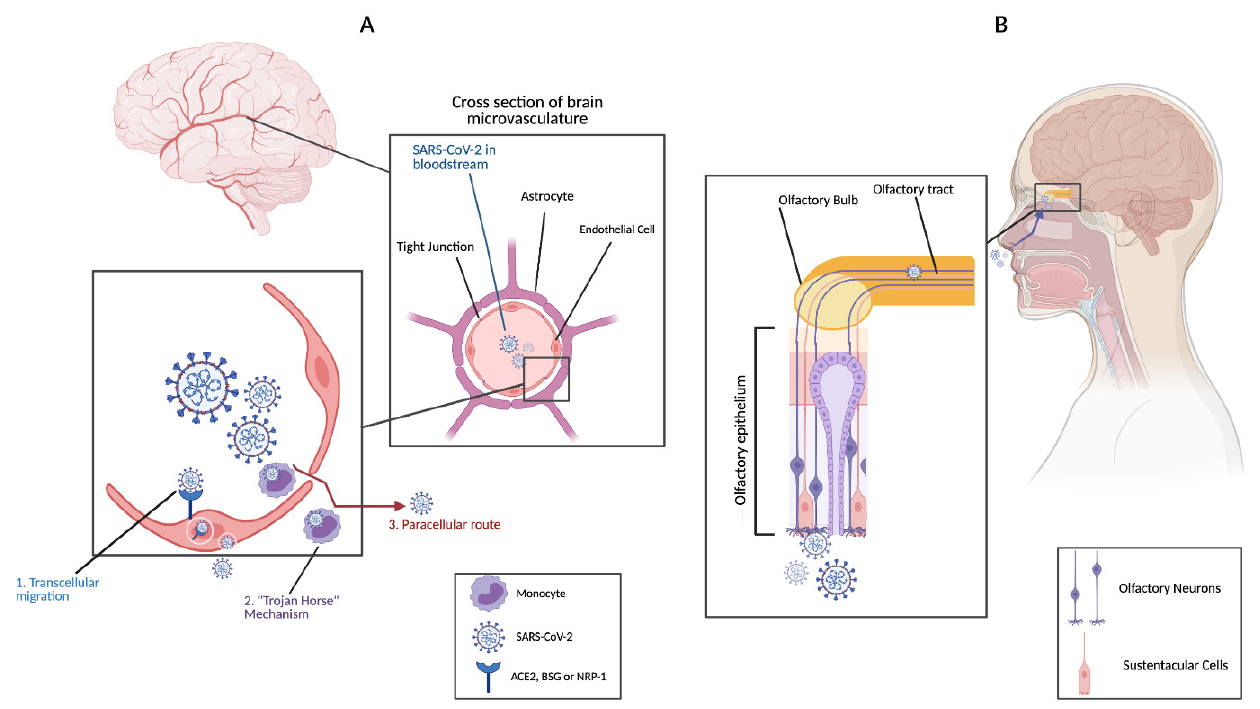
Figure 1. Mechanisms of SARS-CoV-2 invasion of the CNS. ( A ) Hematogenous route: Severe Acute Respiratory Syndrome Coronavirus-2 (SARS-CoV-2) invasion of CNS from the bloodstream is mediated by three mechanisms; 1. Transcellular migration which involves binding of the virus to its receptors; ACE2, basigin (BSG), or neuropilin-1 (NRP-1), on brain microvasculature endothelial cells then crossing endothelial cells via transcytosis, 2. Infecting immune cells which then carry the virus across the blood–brain barrier (BBB) endothelial cells into the CNS (Trojan Horse mechanism), and 3. Paracellular route by disrupting endothelial cells’ tight junctions. ( B ) SARS-CoV-2 infects olfactory epithelium and reaches the CNS via the olfactory neurons. This figure was created with BioRender.com.